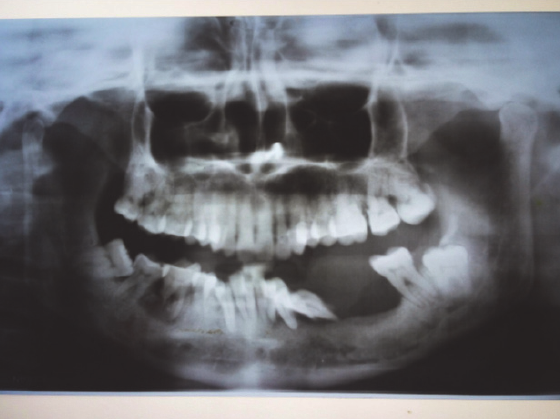
Figure 4: Orthopantomograph.